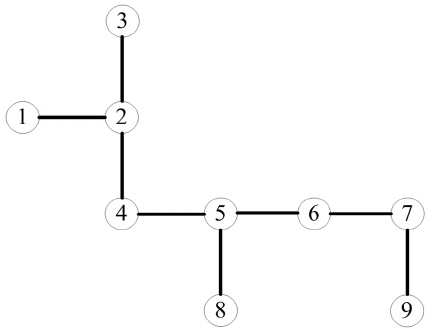
Figure 5. A topology example of 9 antennas (vertices). The circles represent antennas and lines represent mutual couplings between one-hop